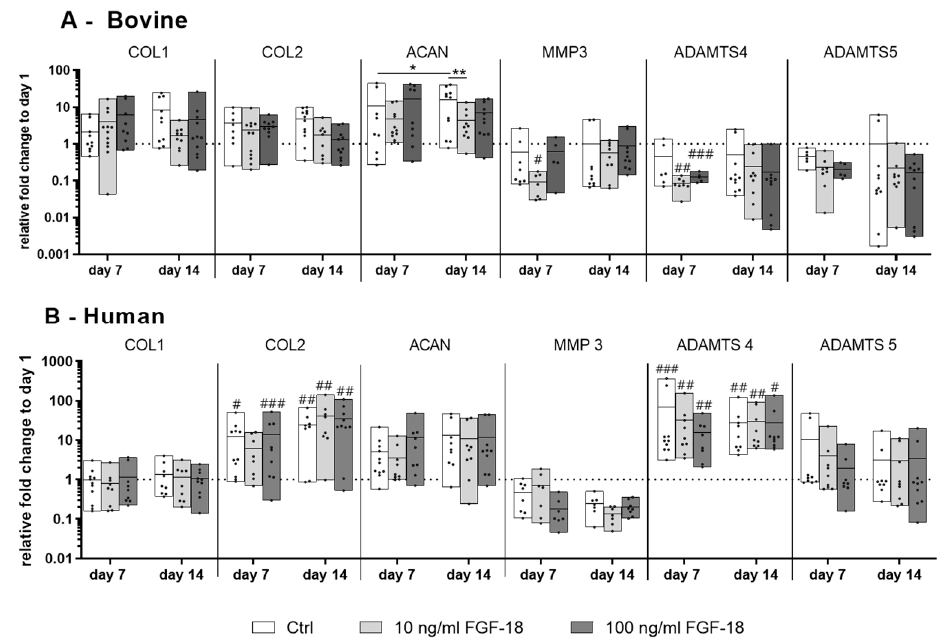
Figure 3. Relative mRNA expression of collagen type I (COL1), collagen type II (COL2), aggrecan (ACAN), and the catabolic markers matrix metalloproteinase-3 (MMP3) and a disintegrin and metalloproteinase with thrombospondin motif 4 and 5 (ADAMTS4 and ADAMTS5) of ( A ) bovine (healthy) nucleus pulposus cells and ( B ) human (mildly degenerated) nucleus pulposus cells encapsulated in FBG-HA hydrogel and stimulated with 10 or 100 ng / mL FGF-18, after 7 or 14 days of culture. Data were normalized to the expression level of cells at day 1 in hydrogel culture. n = 4, # p < 0.05, ## p < 0.01, ### p < 0.001 vs. day 1, * p < 0.05, ** p < 0.01.